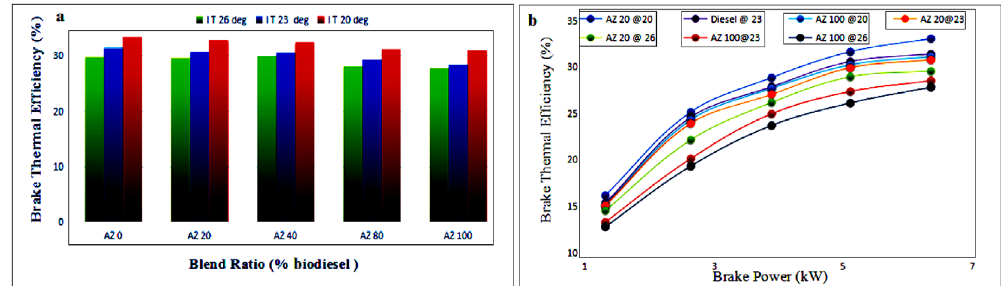
Figure 5. Brake Thermal Ef fi ciency vs. bio blends and brake power.